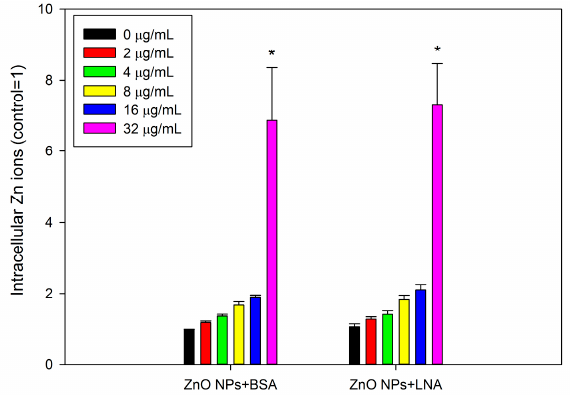
Figure 9. The accumulation of intracellular Zn ions. HepG2 cells were exposed to various concentrations of ZnO NPs (code: XFI06) with the presence of bovine serum albumin (BSA) or α - linolenic acid (LNA complexed to BSA; referred to as LNA) for 3 h, and the accumulation of intracellular Zn ions was measured by using a fluorescent probe. *, p < 0.01, ANOVA, compared with control.